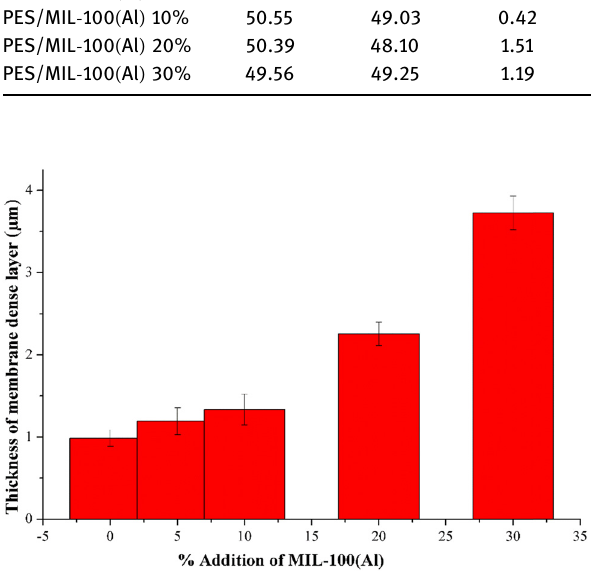
Figure 8: The thickness of PES/MIL - 100 ( Al ) MMMs dense layer with di ff erent percentage additions of MIL - 100 ( Al ) .